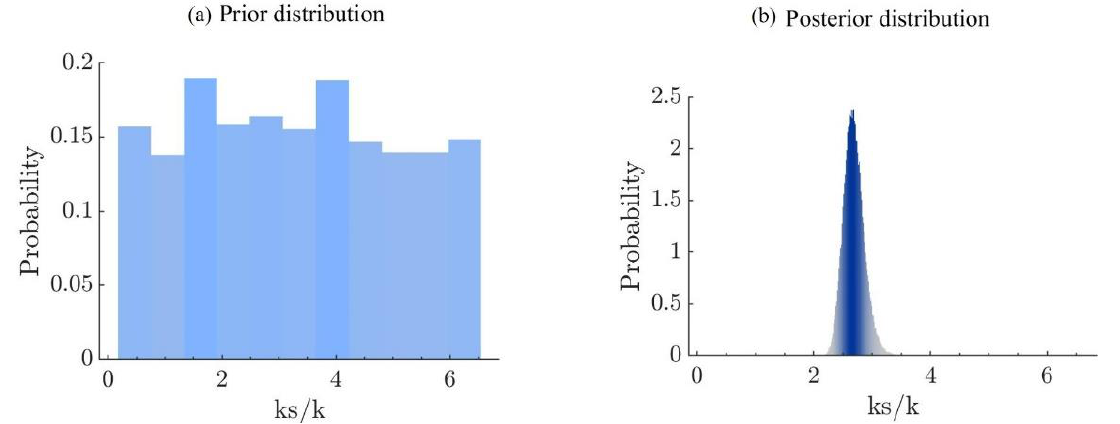
Figure 8. Prior ( a ) and posterior ( b ) distributions for the ratio k s /k ( M 3 calibration). In Figures 7 and 8, it is possible to see the difference from the uncalibrated distributions (prior) to the posterior calibrated distributions. The calibrated values are clearly visible since the distributions are less spread and present peaks. Figures 7 and 8 also allow visualizing graphically the meaning of the mean and MAP values: the mean is the mid value between the distribution’s lower and upper limits, while the MAP value corresponds to the highest peak. From the posterior distributions, it is possible to recover the calibrated values of Table 7 for metamodel M 3 : k = 1.8 mm and k s / k = 2.8 (i.e., k s = 5.0 mm). The observations highlight that the ratio k s / k (Figure 8b) is finely calibrated with a smaller uncertainty compared to the roughness height k (Figure 7b). The posterior distribution for the ratio k s / k exhibits a narrower peak, typical of a small